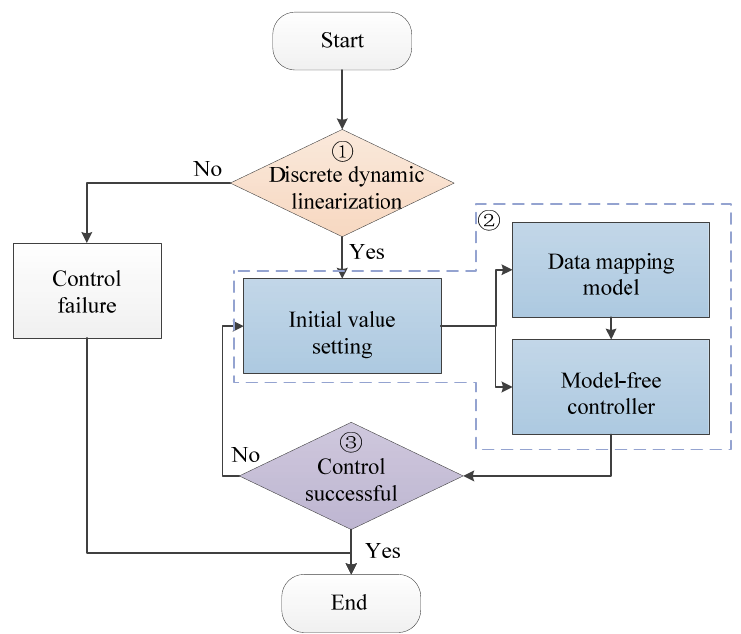
Figure 3. Control flow of the model-free control method.